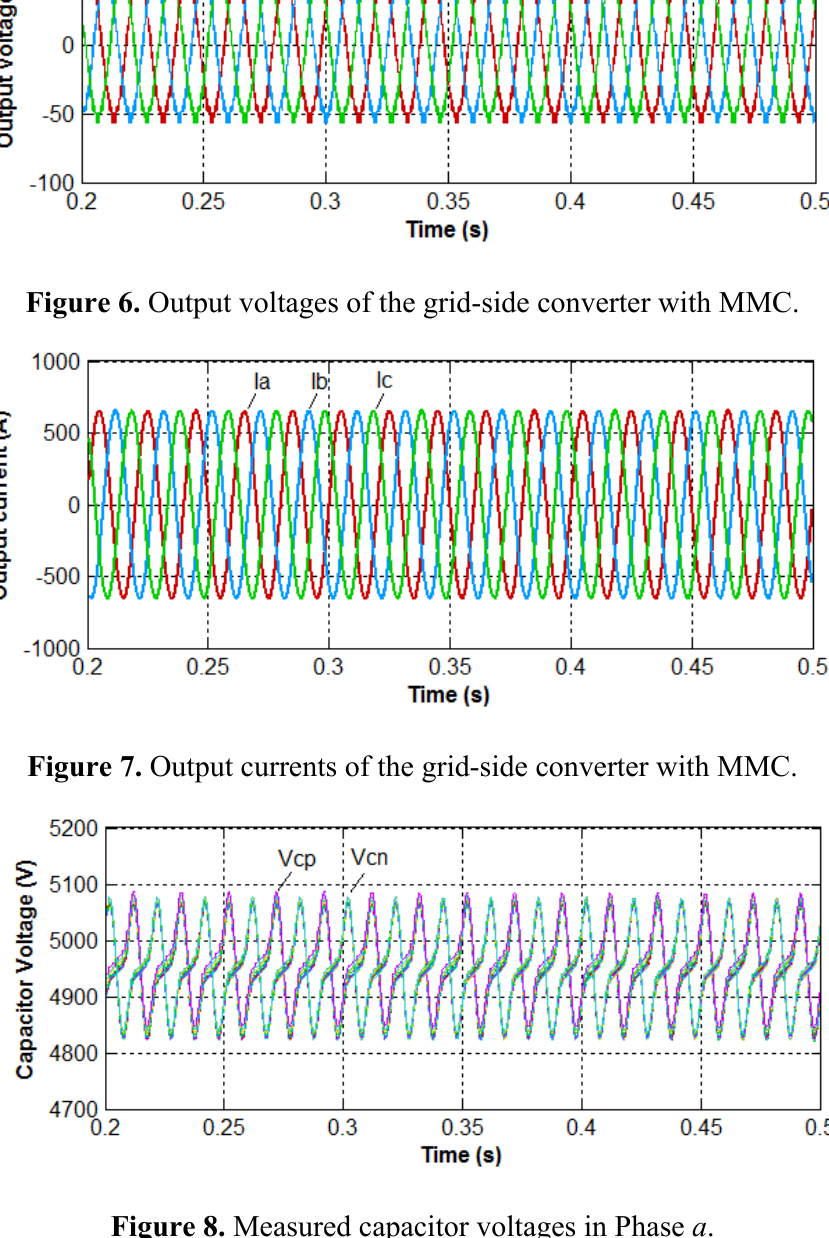
Figure 8. Measured capacitor voltages in Phase a